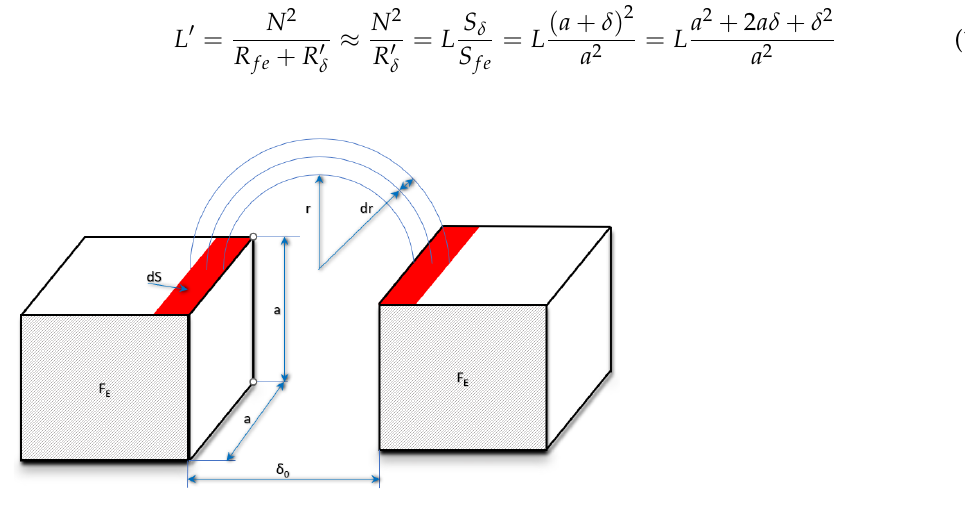
Figure 2. Simplified magnetic leakage field.